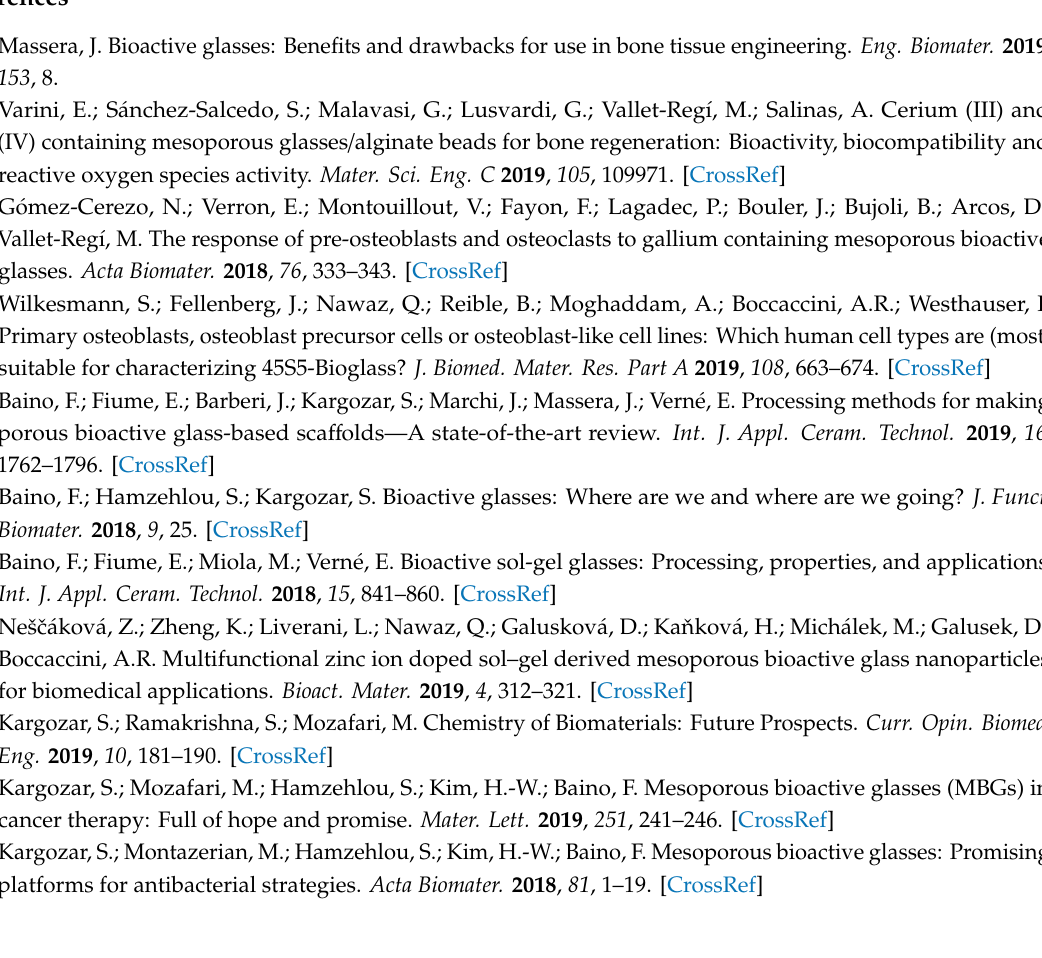
Figure S1: Compositional analyses (EDS) performed on the MBGs after calcination, Figure S2: Particle size distributions assessed by